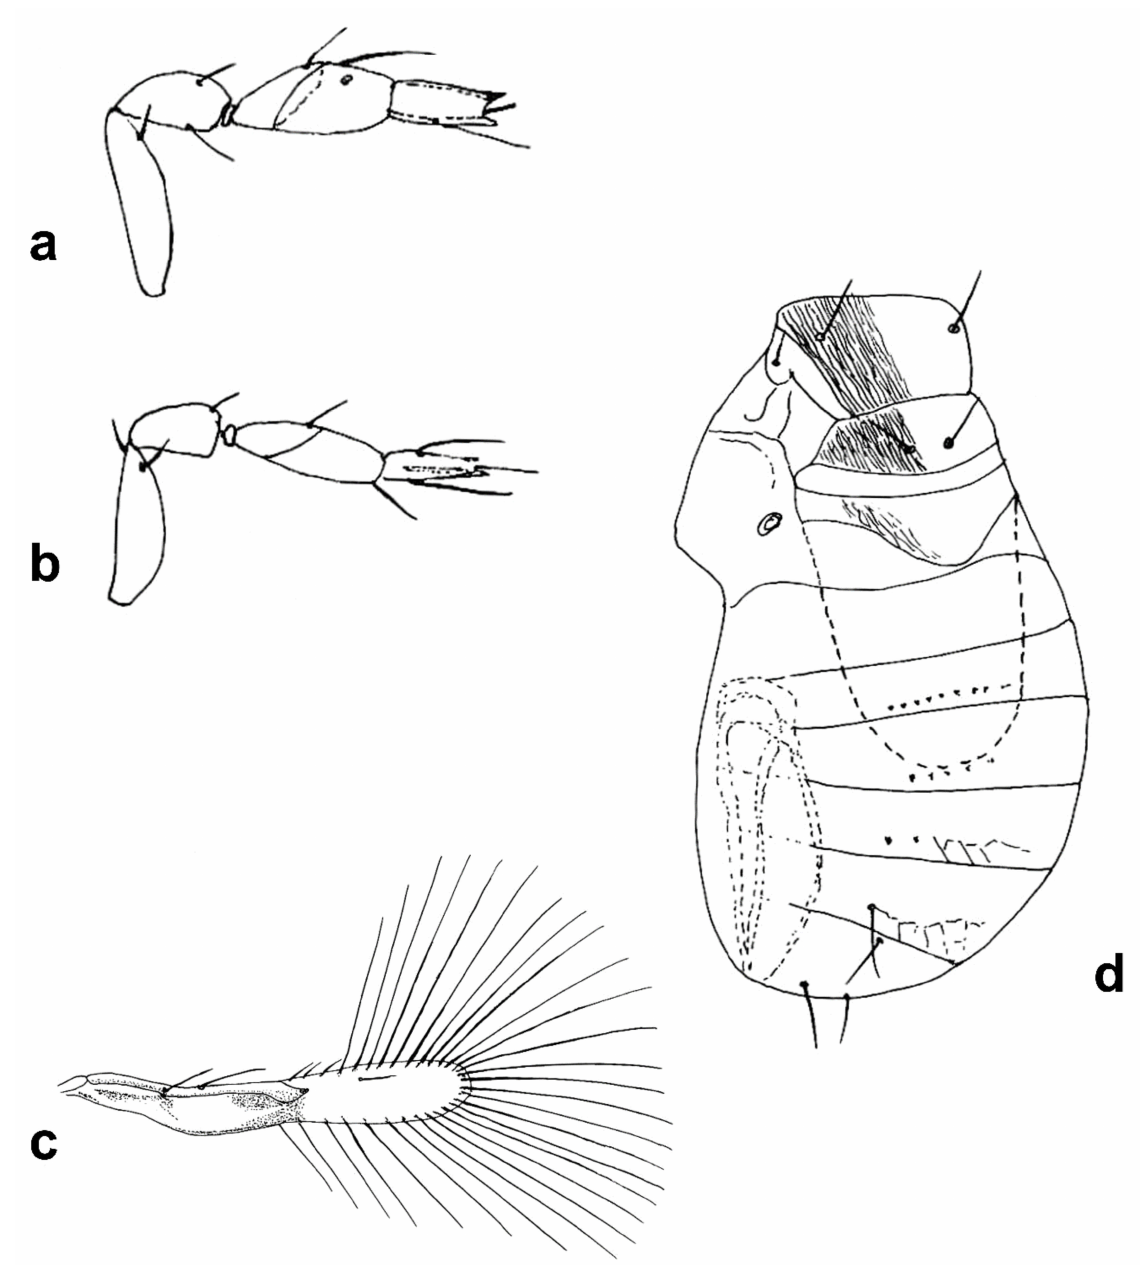
Figure 10. Line drawings of Megaphragma species: ( a ) M. striatum , female antenna (Holotype); ( b ) M. striatum , male antenna (Paratype); ( c ) M. striatum , female fore wing (Holotype); ( d ) M. striatum , female dorsal meso- and metasoma